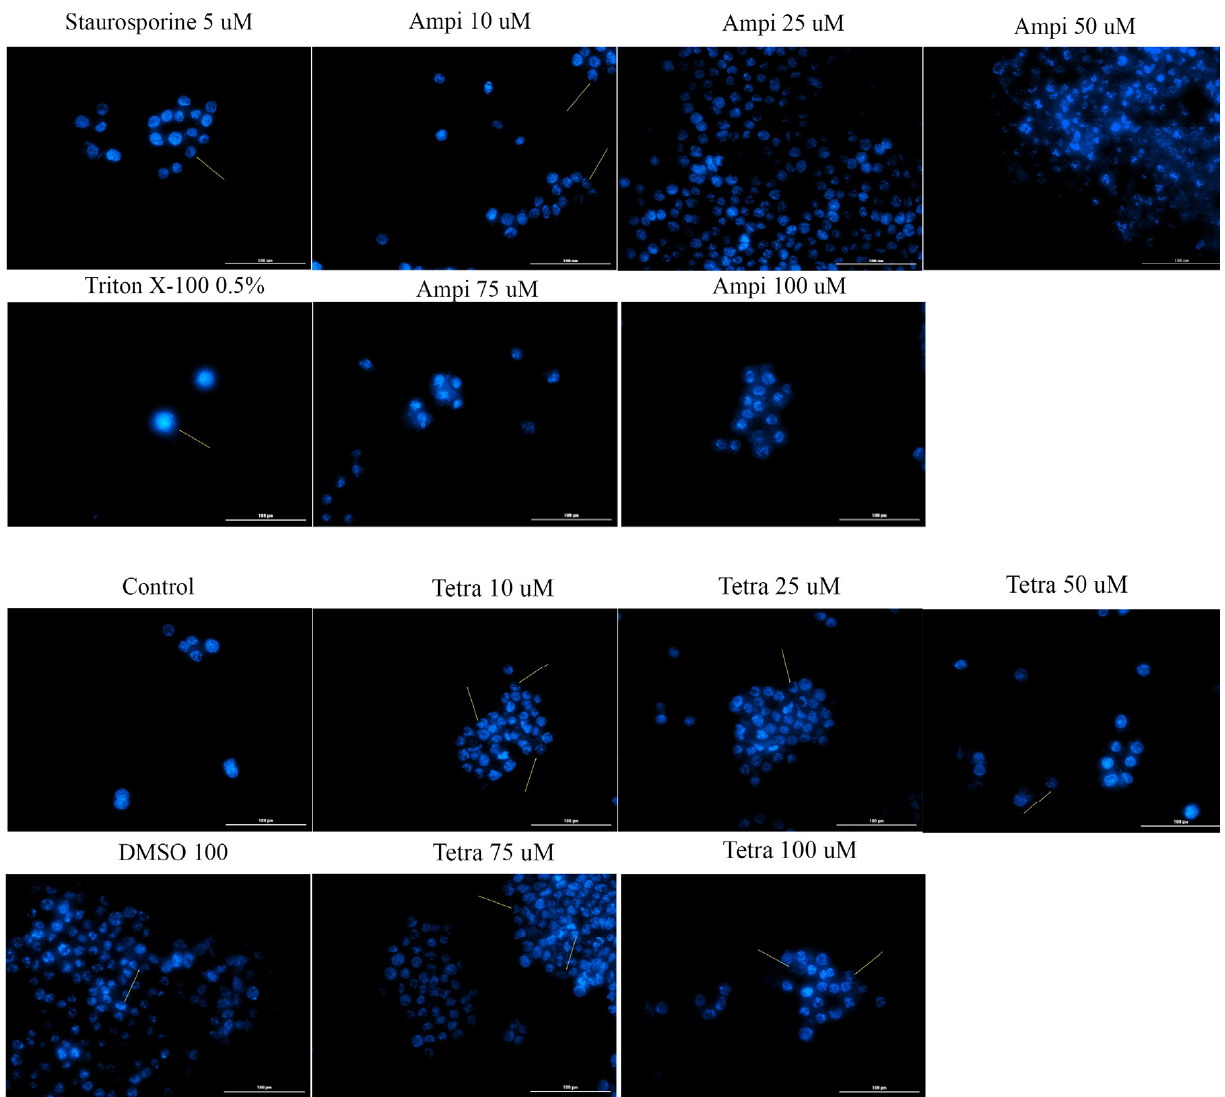
Figure 7. Cell nuclei staining using Hoechst 33342 in HT-29 cells after treatment with ampicillin and tetracycline (10, 25, 50, 75, and 100 µ M) and DMSO for 24 h. The pictures were taken at 24 h post-treatment. Staurosporine solution (5 µ M) represents the positive control for apoptotic changes and Triton X-100 solution (0.5%) for necrosis. The scale bar was 20 µ